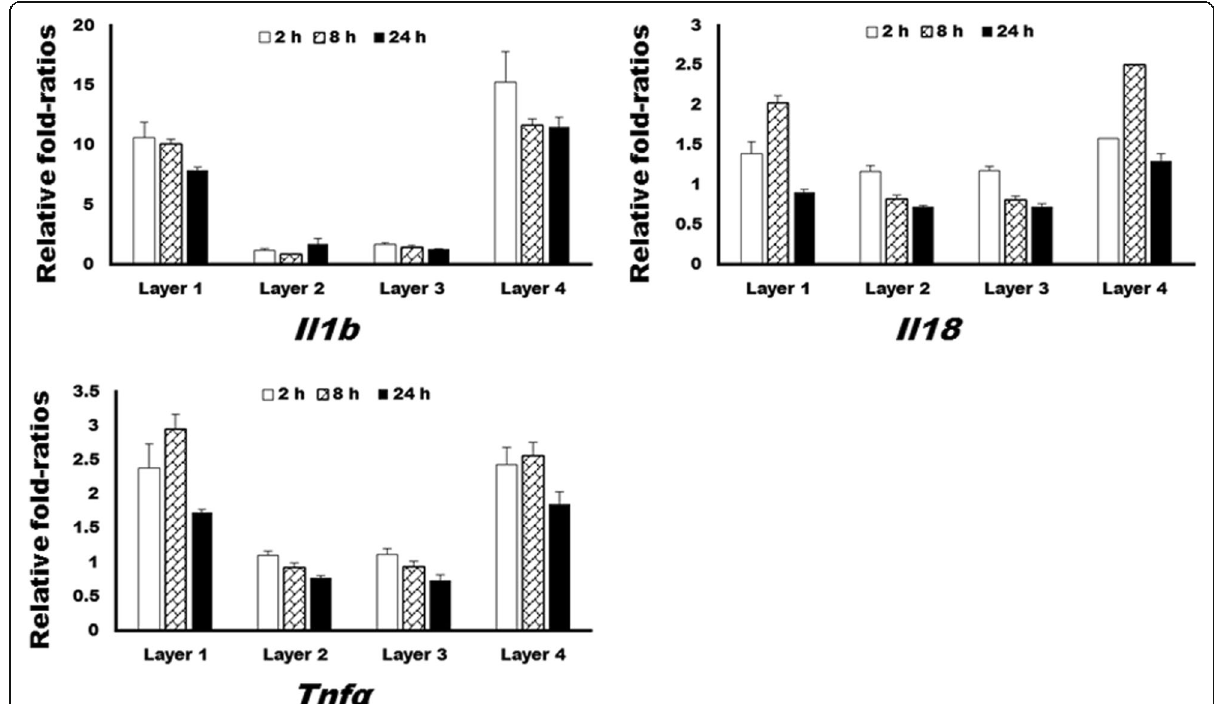
Fig. 3 The results of quantitative reverse-transcriptase polymerase chain reaction (qRT-PCR) analysis of selected genes. The expression of Il1 β , Il18 , and Tnf α at 2 and 8 h was significantly higher in layer 1 and 4 groups than in layer 2 and 3 groups ( P < 0.05). The expression of Il1 β and Tnf α at 24 h was significantly higher in layer 1 and 4 groups than in layer 2 and 3 groups ( P <